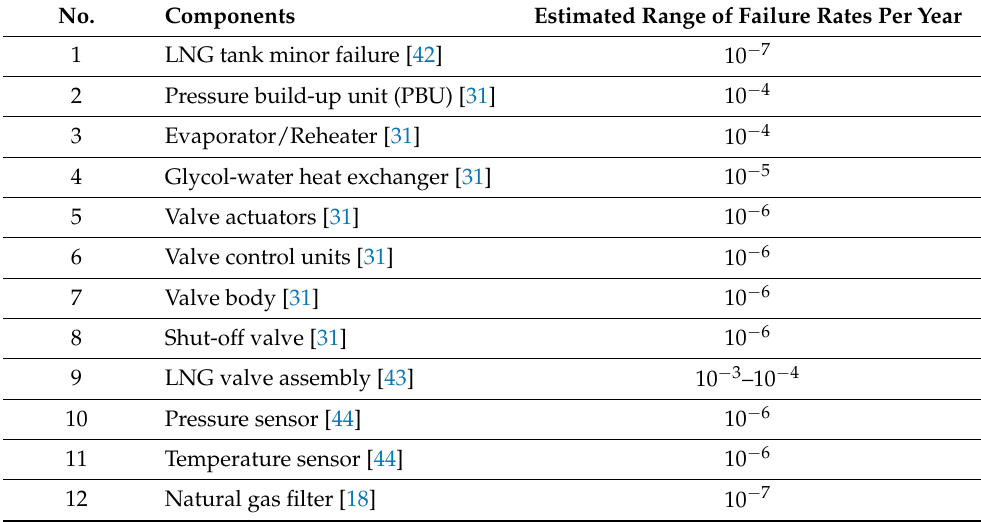
Table 3. Component failure rates adopted from published historical